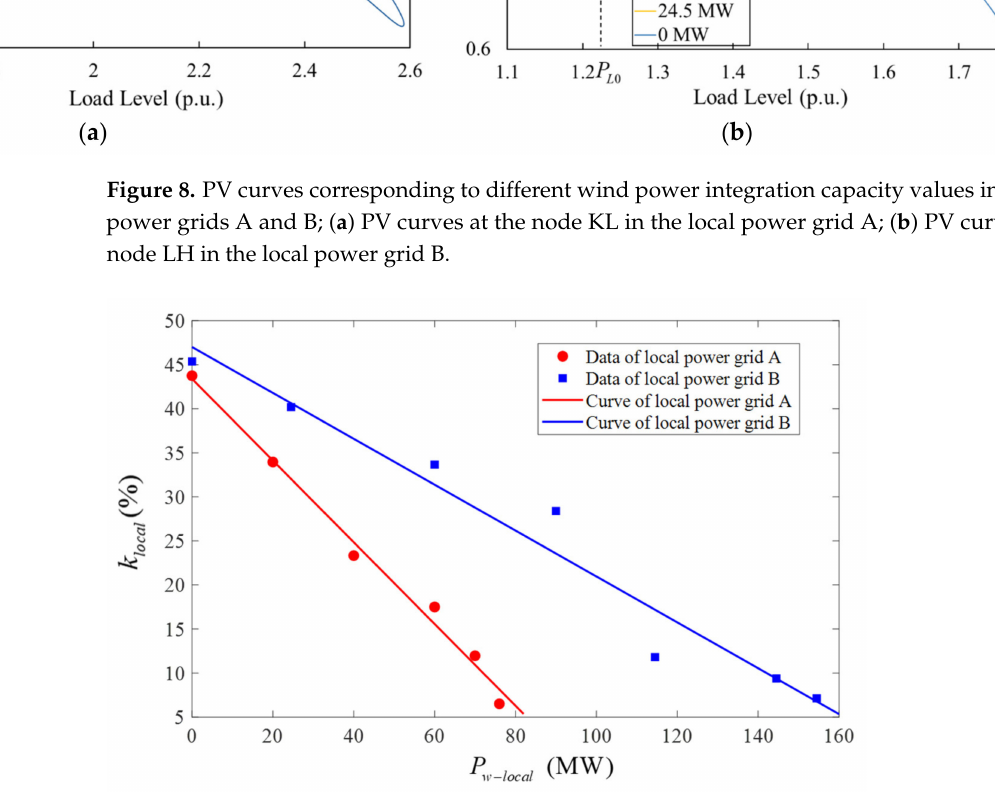
Figure 9. Approximate fitted curves of the relationship between k local and P w − local .